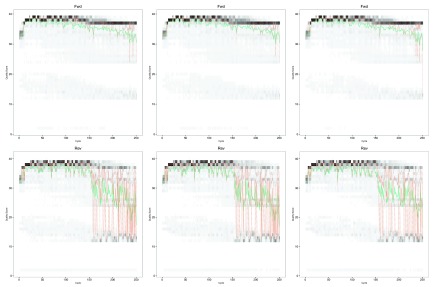
Forward and Reverse Error Profiles, the mean is in green, the median the solid orange line and the quartiles are the dotted orange lines.